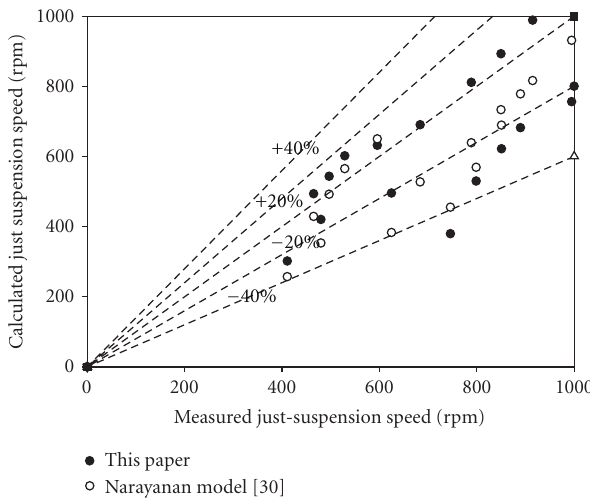
Figure 10: Comparing N JS calculated from semitheoretical model proposed in this work with model and experimental data proposed by Narayanan et al.